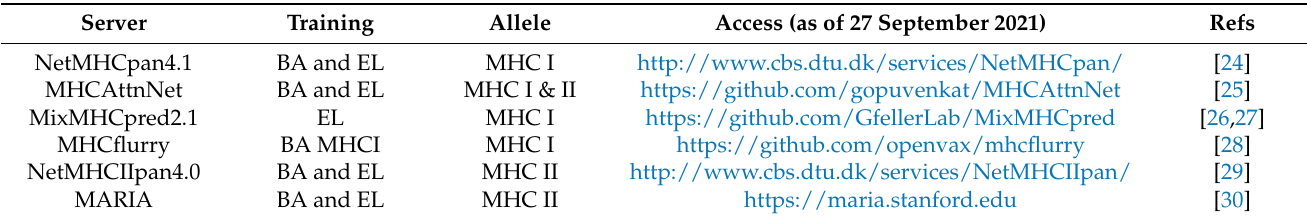
Table 1. MHC binding prediction tools for neoantigen